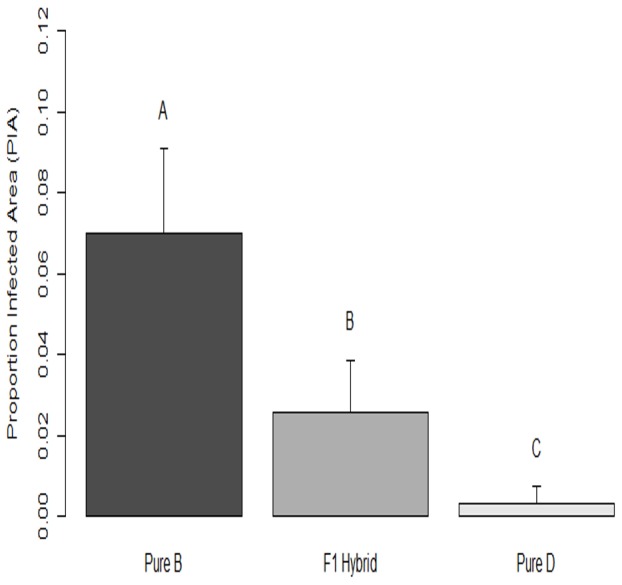
Disease severity measured as the proportion infected area and 95% confidence interval of the mean.The three genotype classes (Pure B, F1 Hybrid, and Pure D) are represented with bars. Bars with different letters above them are significantly different (P<0.10) from each other.